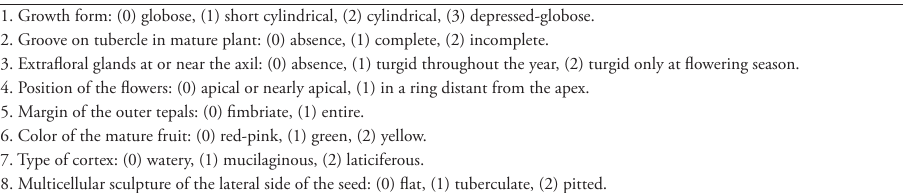
Table 2. Characters and character states for the ancestral states